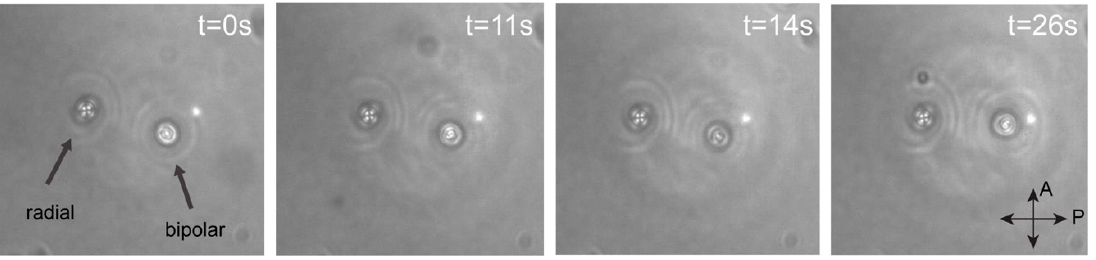
Figure 11. Both radial and bipolar droplets were trapped by the optical tweezers. Radial droplet texture remains the same due to its symmetric configuration while bipolar droplet showed continuous rotation in the laser trap.